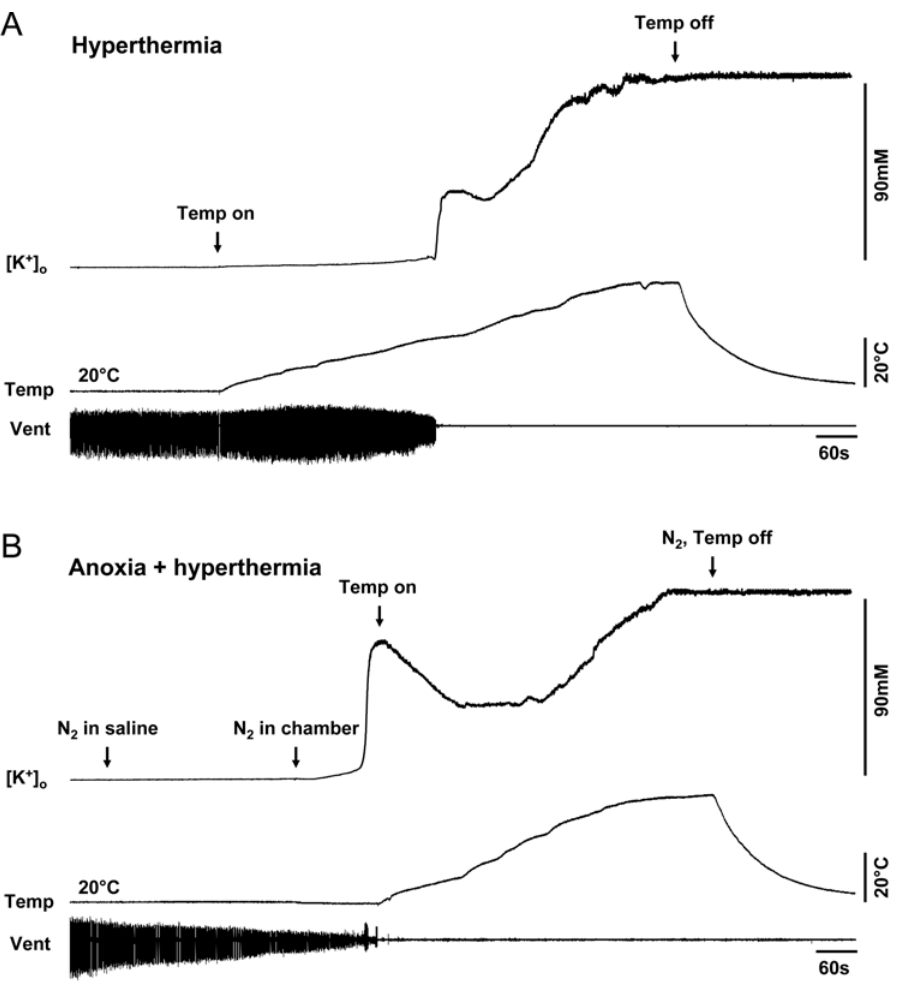
Figure 3. The hyperthermic [K + ] o event is not representative of complete collapse of the K + gradient. A. During a continuous increase of temperature [K + ] o increased sharply at , 40 u C coincident with motor pattern failure and continued to rise until a second plateau was reached at , 60 u C. When the heater was turned off [K + ] o remained elevated and motor pattern generation failed to recover (N=11). B. Only the second plateau was evident during temperature increase to , 60 u C following prior anoxic arrest of motor pattern generation. When the N 2 was turned off and internal temperature returned to room temperature [K + ] o remained elevated and motor pattern generation failed to recover (N=12).